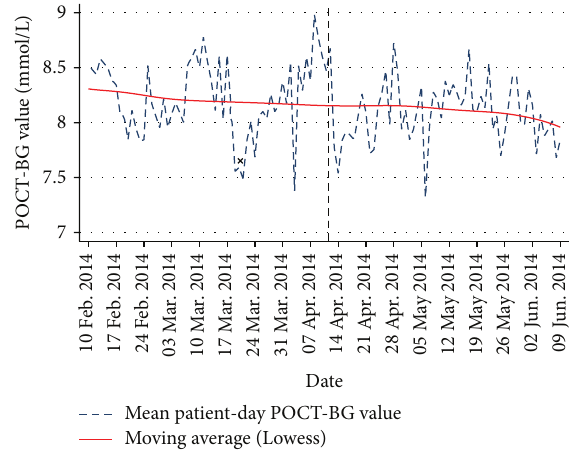
Figure 3: Line graph and Lowess moving average of hospital mean patient-day weighted POC-BG value over time. There was a significant decrease after the date of implementation of the alert system, as highlighted by the dashed line. “x” marks the time period when new hospital guidelines were implemented for the management of inpatient dysglycaemia.